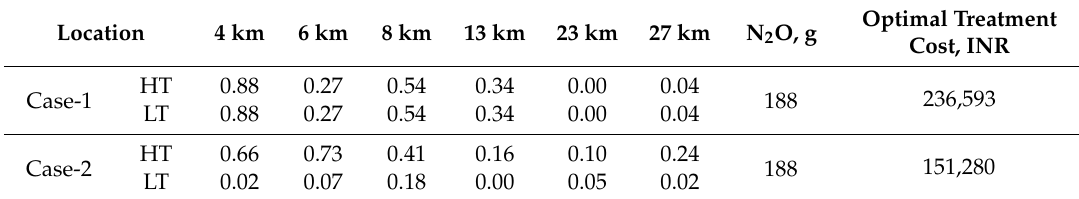
Table 1. Optimal operating schedule: